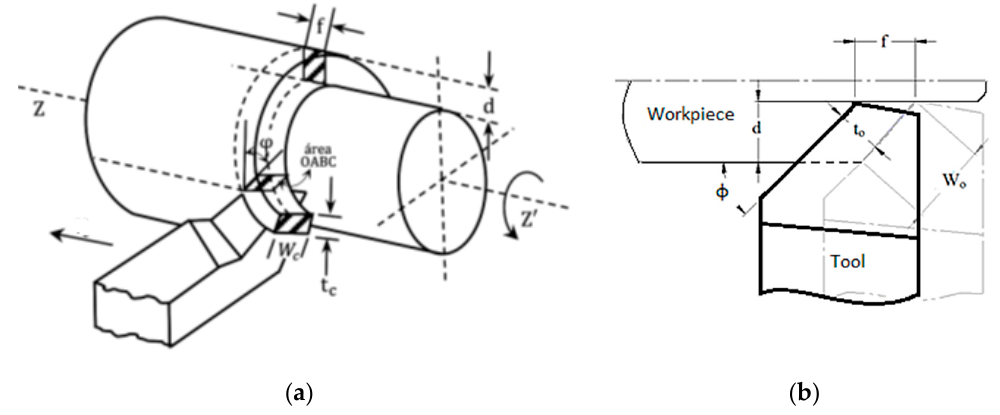
Figure 2. Basic geometry of an oblique turning process. ( a ) OABC plane; ( b ) Some variables in oblique cutting.